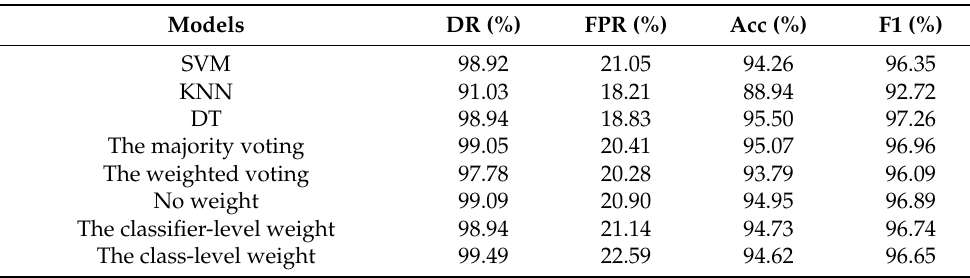
Table 9. Performance comparisons of the base learners and different voting ensemble methods with feature selection on the UNSW-NB15 dataset.